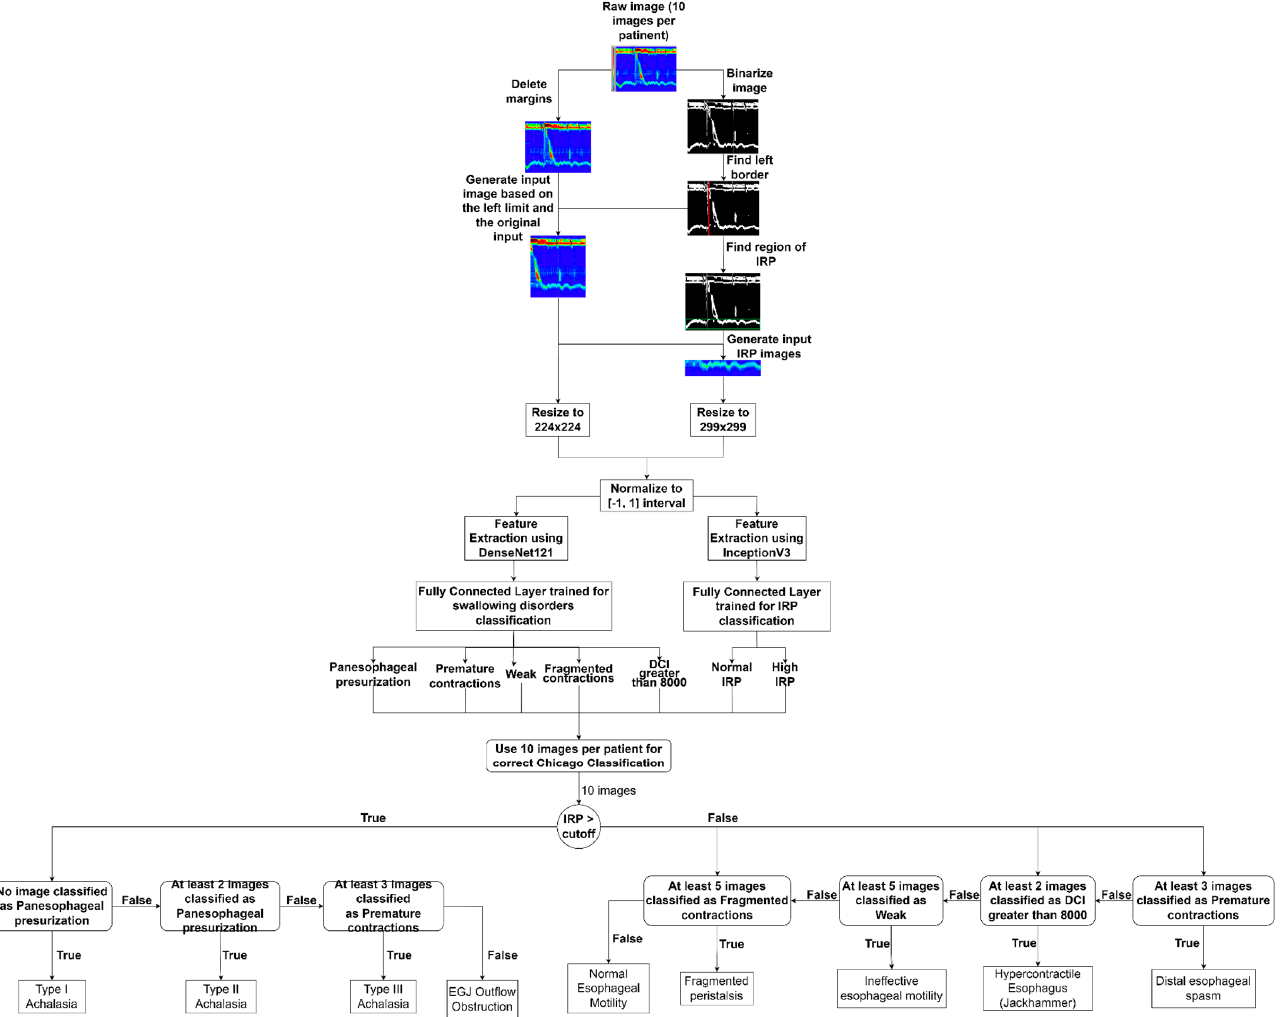
Figure 5. Solution